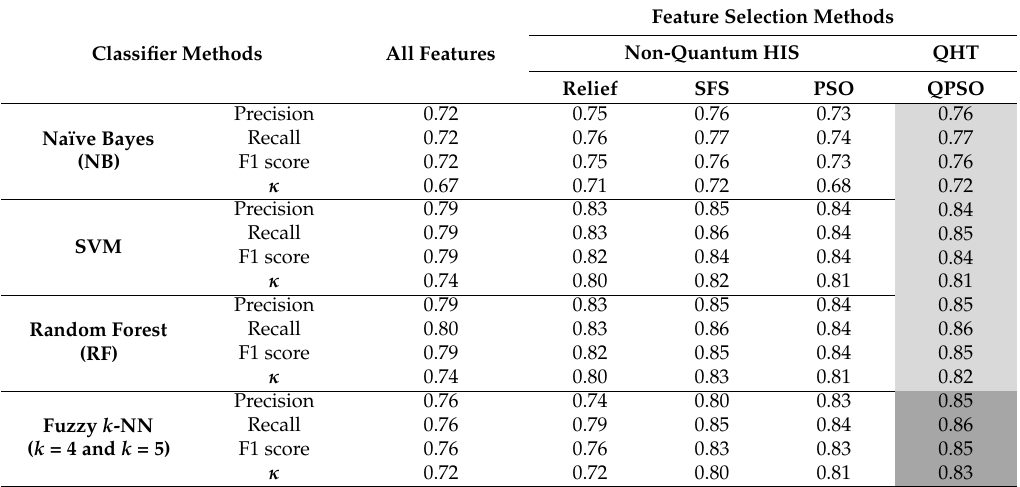
Table 7. Comparison of classification outcomes between hybrid QH approaches that combine QPSO with Naïve Bayes, Support Vector Machines (SVM), Random Forest (RF), and Fuzzy k